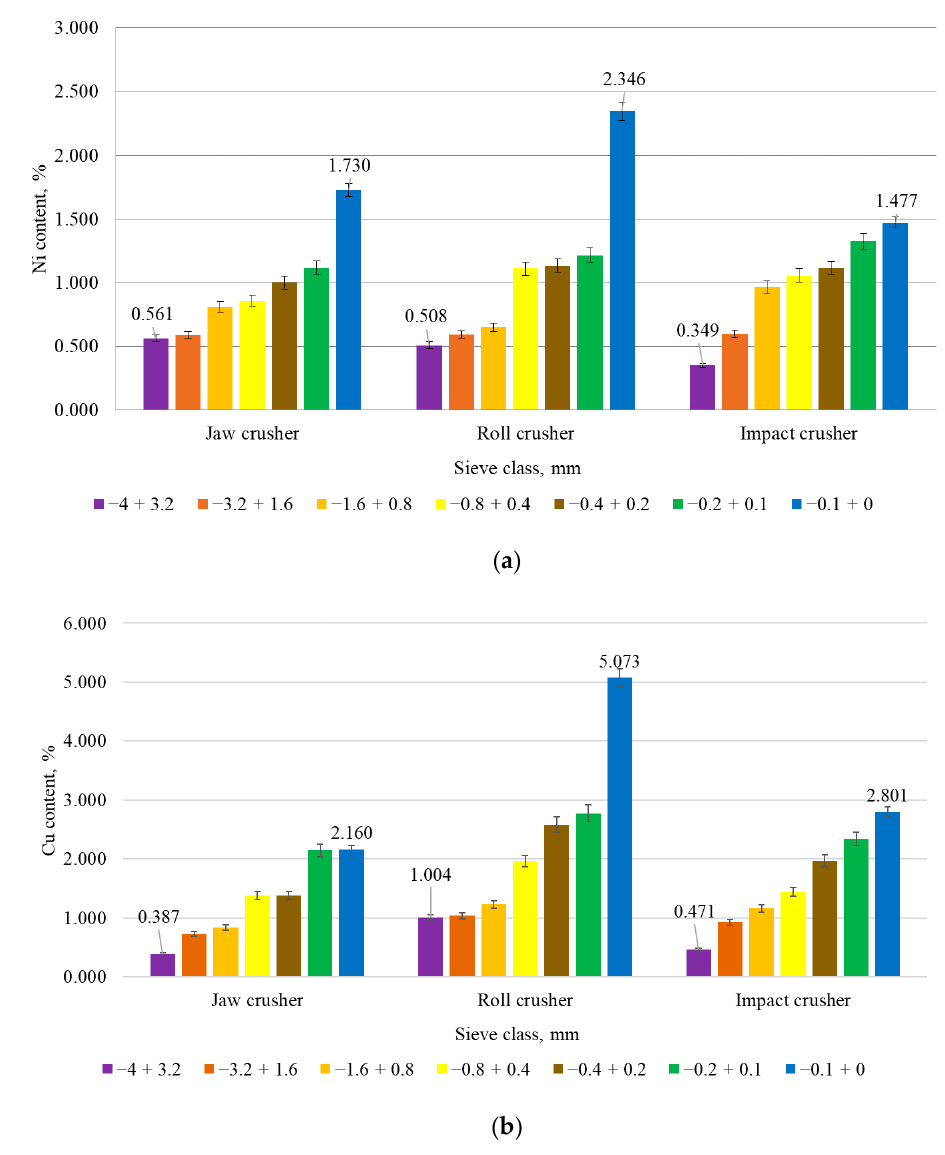
Figure 8. Nickel ( a ) and copper ( b ) content in the sieve classes of the crushing of CNO samples in jaw, roll and impact crushers.